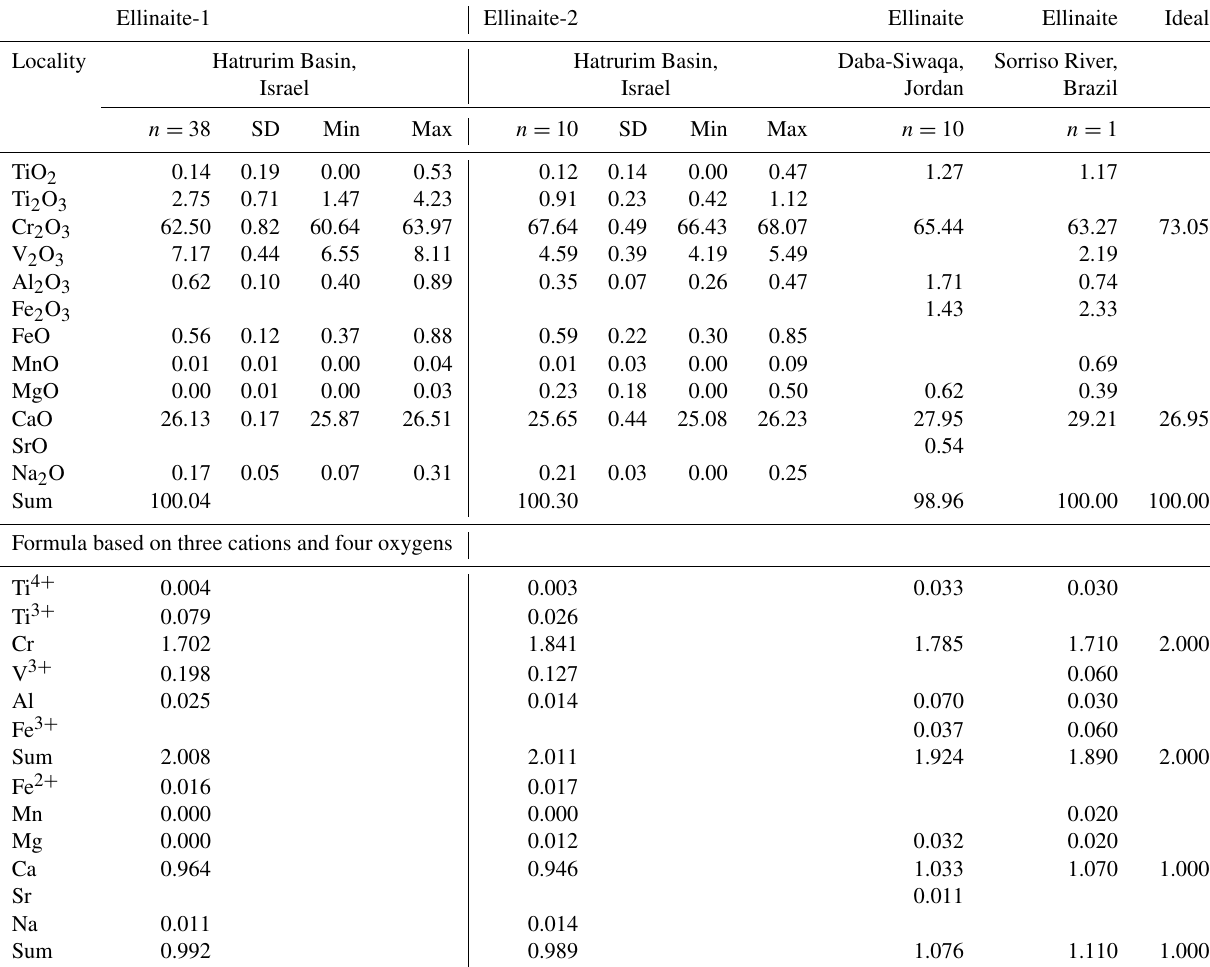
Table 2. Chemical composition (in wt%) for ellinaite from rankinite–gehlenite paralava (sample MP-2013-6), Hatrurim Basin, in comparison with ellinaite from the Daba-Siwaqa spurrite marble and the Brazilian diamond and ideal composition CaCr 2 O 4 .